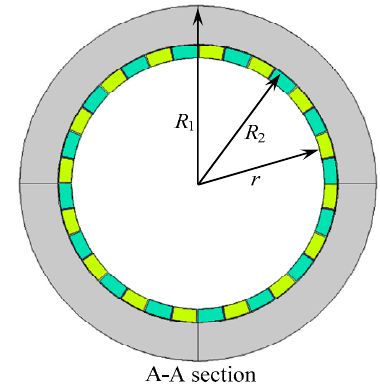
Figure 19. The ADCAA system.